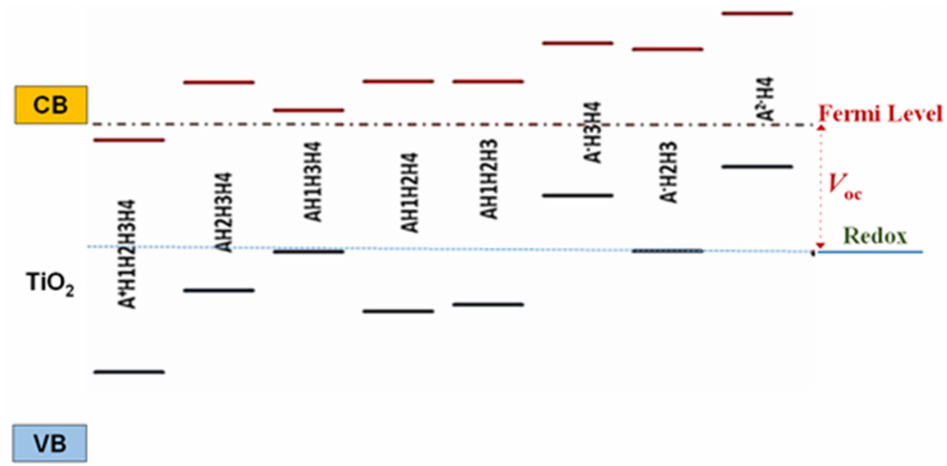
Figure 4. Diagram of energy level alignment of TiO 2 , various deprotonated species of cyanidin 3-glucoside, and the redox level of the electrolyte. Energy is relative to vacuum